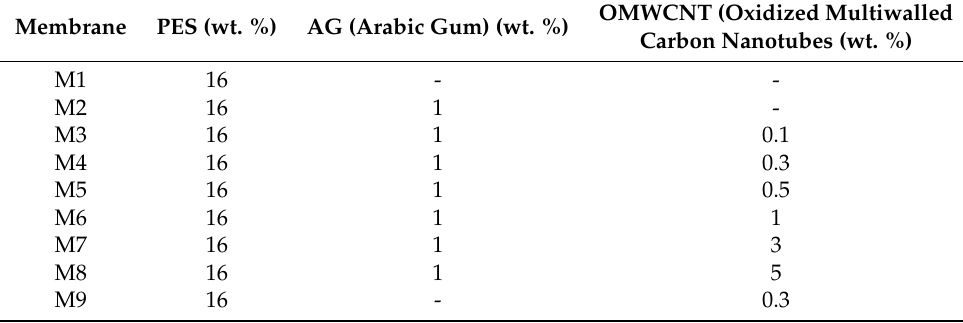
Table 1. Composition of cast polyethersulfone (PES) membranes. M1 is a neat PES membrane. N,N-dimethylacetamide (DMA) solvent was used in the preparation of all membranes.